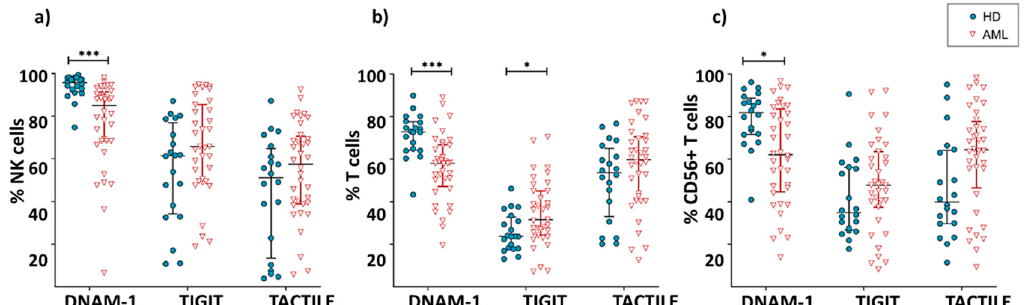
Figure 1. Expression of DNAM-1, TIGIT and TACTILE. Percentage of NK cells ( a ), conventional CD56 − T cells ( b ) and CD56 + NKT-like cells ( c ) expressing DNAM-1, TIGIT and TACTILE in AML patients ( n = 36) and HD ( n = 20). Vertical lines indicate interquartile ranges from the 25th to the 75th percentile. The horizontal lines represent the median values. Results were considered significant at * p = 0.02 and *** p < 0.001. HD: healthy donors, AML: acute myeloid leukemia patients.